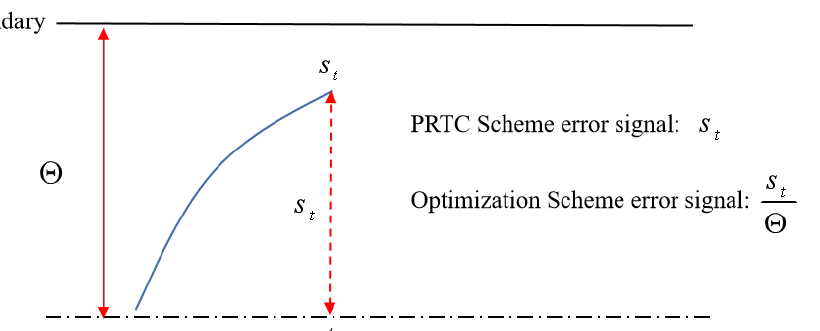
Figure 4. Schematic diagram of control law optimization scheme.